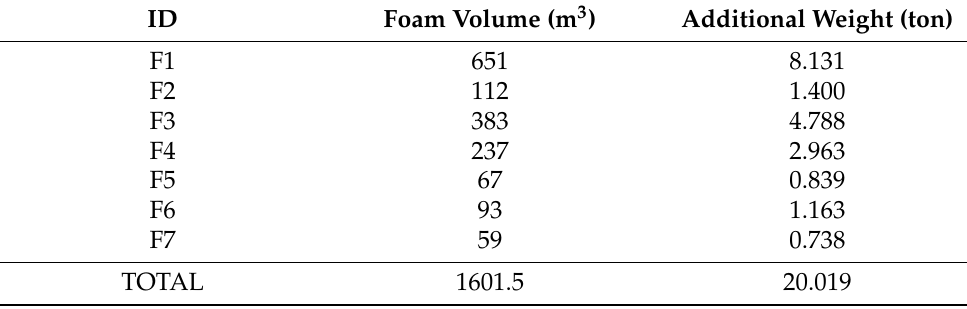
Figure 18. AREST P1 permanent foam installations for cruise ship C1. Table 7. AREST P1 foam installation volumes and weights.